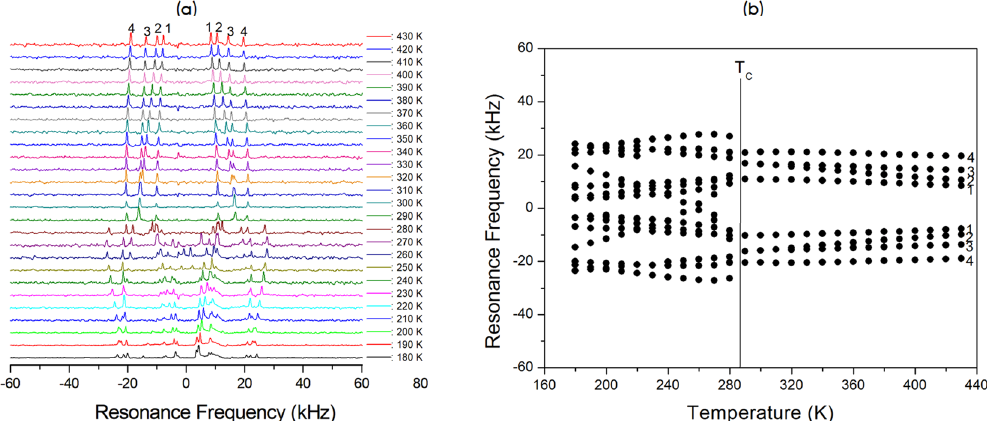
Figure 10. ( a ) In-situ 14 N NMR spectrum as a function of temperature for [N(CH 3 ) 4 ] 2 Zn 1- x Cu x Br 4 ( x = 0.7). ( b ) Resonance frequency of the 14 N NMR spectrum as a function of temperature for [N(CH 3 ) 4 ] 2 Zn 1- x Cu x Br 4 ( x = 0.7).